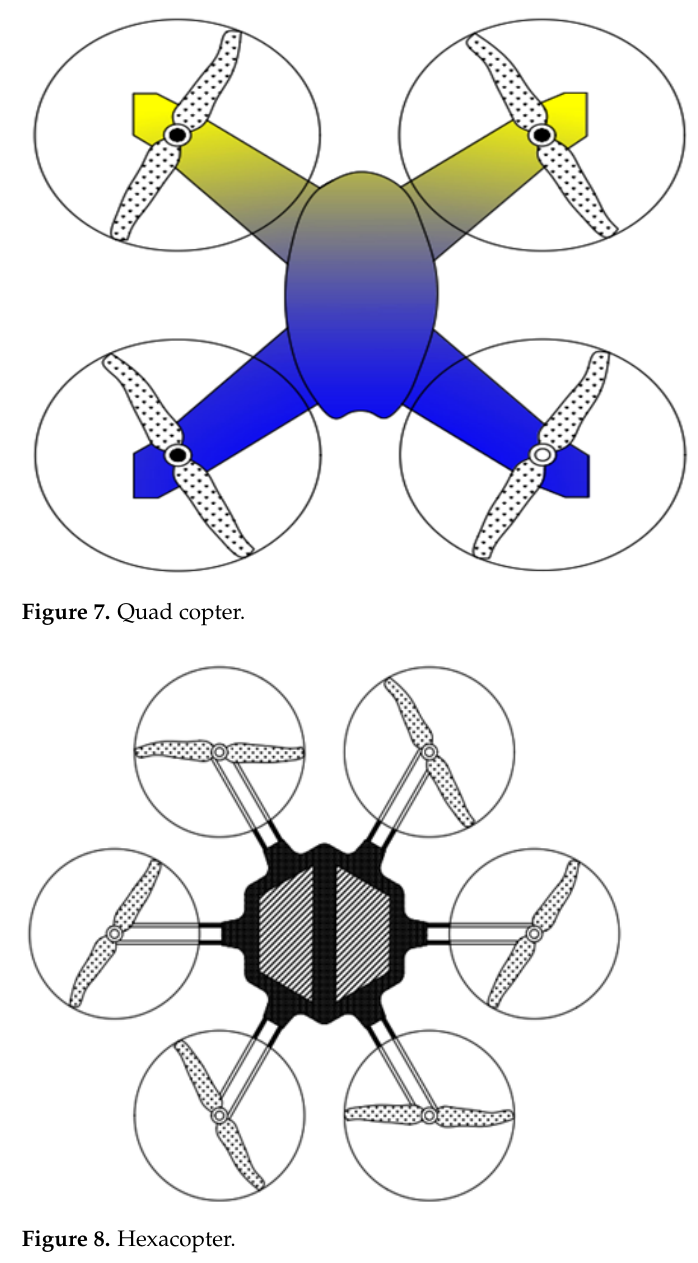
Figure 9. Octo copter. 4. Role of UAV in Precision Pest Management Precision pest management can be used for monitoring the crops which identify the pest-affected places using remote sensing technologies, and control mechanisms such as pesticide spraying will be acted accordingly from prevention of diseases. For achieving this, both the technologies should be mounted on the UAV. The Unmanned aerial vehicle can also be used for spraying fertilizer and pesticides on agricultural fields [9]. The UAV has a significant feature with good speed and accu- racy in spraying system of the fertilizer and pesticides. The main parts of UAV used for spraying are: •